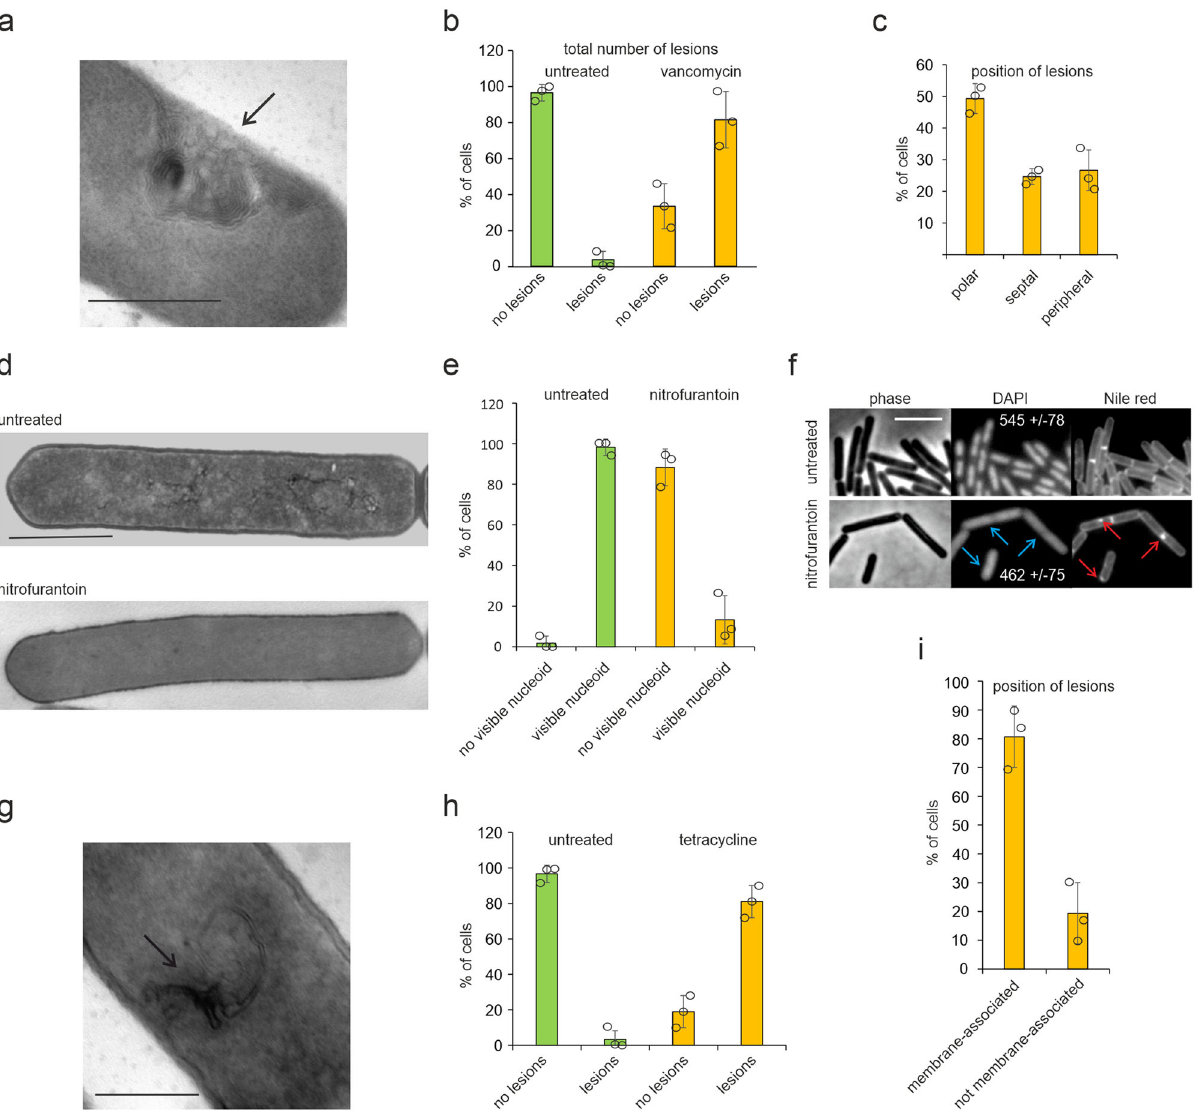
Fig. 3 Quanti fi cation of antibiotic-induced lesions based on electron micrographs. a TEM image showing cell wall damage (arrow) caused by vancomycin. Scale bar 500 nm. b Quanti fi cation of the total number of lesions caused by vancomycin. c Position of cell wall lesions in vancomycin-treated cells. d TEM images showing deterioration of nucleoids caused by nitrofurantoin. Scale bar 1 µ m. e Quanti fi cation of cells devoid of visible nucleoids in electron micrographs. Note that all nitrofurantoin-treated cells with visible DNA structures displayed a deteriorated nucleoid as shown in Supplementary Fig. 6. f Fluorescence light microscopy images of B. subtilis stained with the DNA dye DAPI and the membrane dye Nile red. Blue arrows indicate diffuse DNA stain. Numbers in the DAPI panels show average cell fl uorescence quanti fi ed from three different data sets using the ImageJ analyze particles function. Red arrows indicate membrane patches. Cells were treated with 4x MIC of nitrofurantoin for 30 min. Scale bar 3 µ m. g TEM image showing a lesion (arrow) caused by tetracycline. Scale bar 500 nm. h Quanti fi cation of total lesions in cells treated with tetracycline. i Quanti fi cation of different types of membrane lesions caused by tetracycline. ( b , c , e , h , i ) Cells were quanti fi ed manually from electron micrographs at 8000 to 15,000x magni fi cation according to their phenotype ( n ≥ 100 per condition per replicate). Error bars represent the standard deviation of three biological replicates. Circles indicate individual